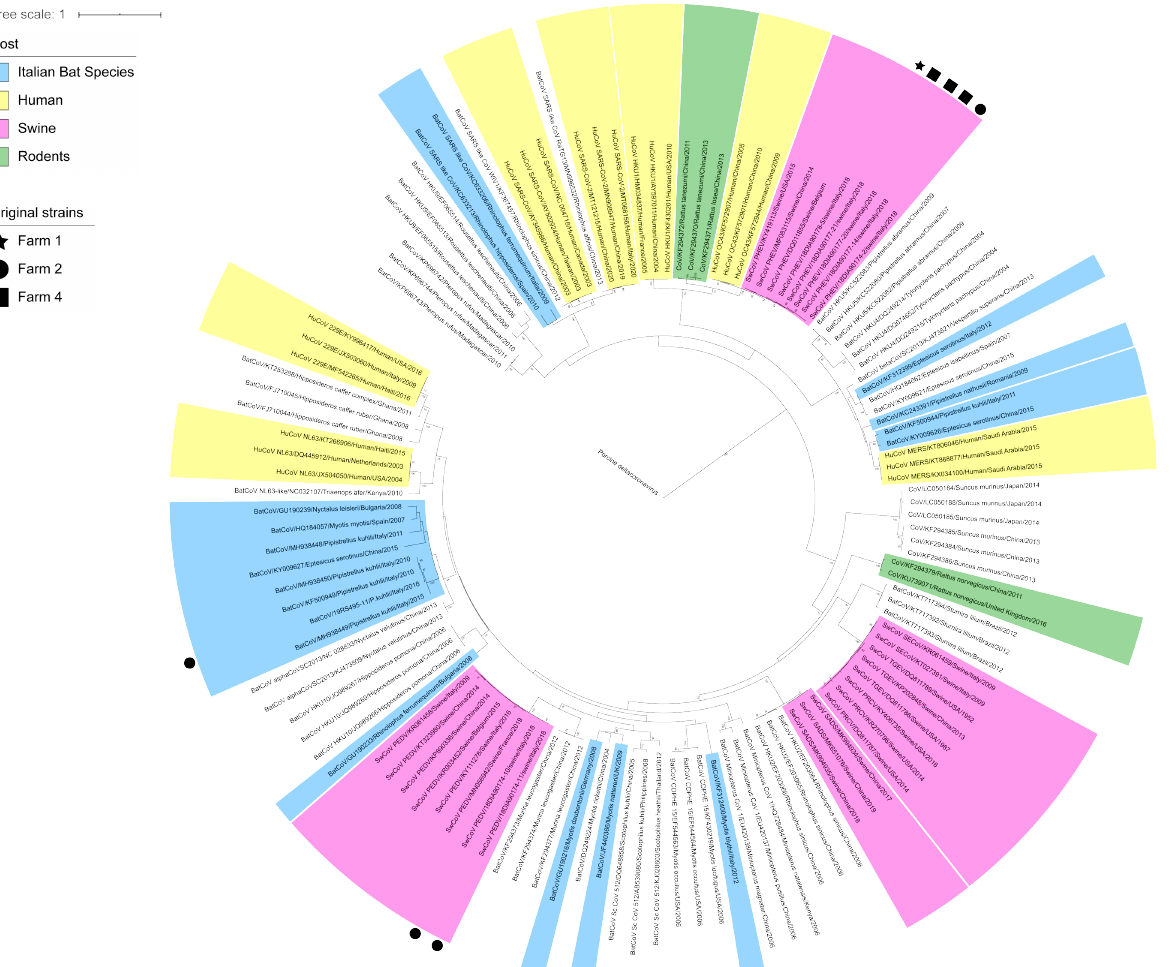
Figure 2. Phylogenetic tree based on the RdRp of alpha and betacoronaviruses. Sequences are coloured based on the host species, with original sequences marked according to the farm of